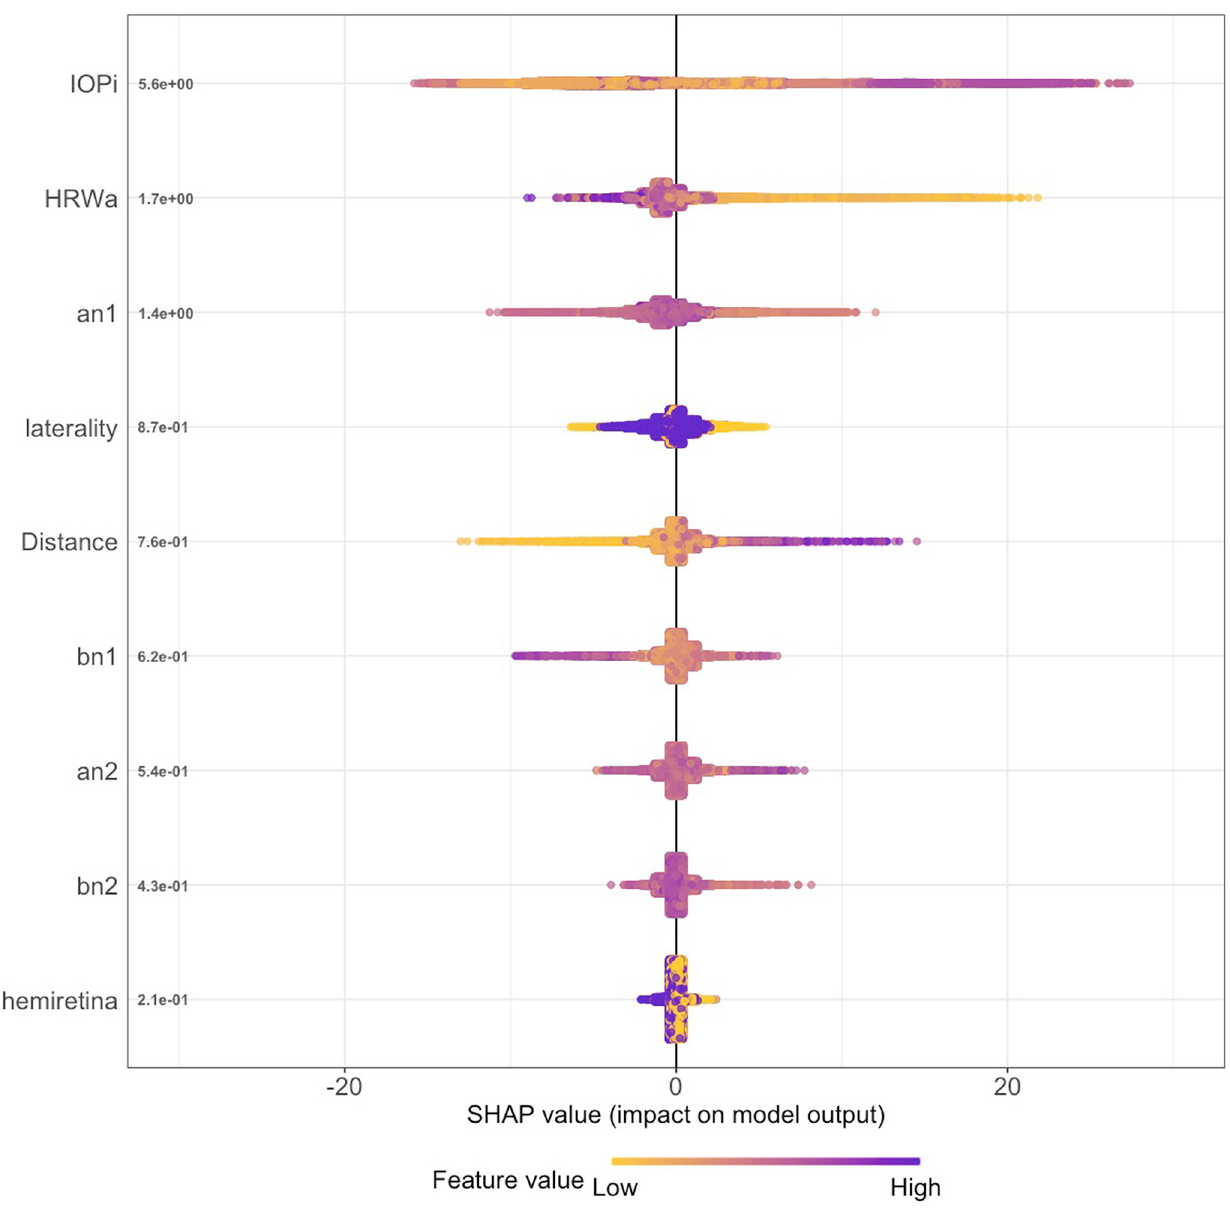
Fig 10. SHAP summary plot retinal venous model demonstrating the feature contribution of the XGB model predicting ICP from the venous model. Induced intraocular pressure (IOP i ) was the most important feature in the model (mean SHAP = 5.723), approximately four times the value of the harmonic regression wave amplitude (HRW a mean = 1.425). HRW a =Harmonic regression wave amplitude, a n1,2 , b n1,2 =cosine and sine coefficients of the first and second harmonics, laterality = Right/Left eye, Distance = Retinal vascular pulsation amplitude as a function of distance from the center of the optic disc in mm, hemiretina = Superior/Inferior retina.